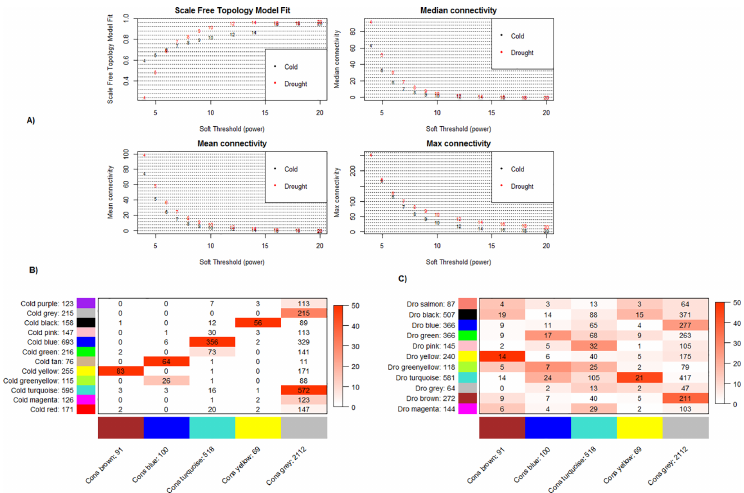
Fig 6. Consensus module detection and comparison. (A) The plots depicting various network indices (y-axes) as functions of the soft- thresholding power (x-axes). Numbers in the plots represents soft-thresholding powers. The plots demonstrate that 10 is the smallest soft-thresholding power at which approximate scale-free topology is accomplished for both sets as the various connectivity measures decrease sharply with increasing soft-thresholding power. (B) and (C) Relation between consensus modules and modules found individually in cold and drought expression set. The table represents the analogy between consensus modules and modules of cold and drought stress related global co- expression network based on the expression values of the common genes. Each row of the table represent individual stress specific module and each column represent one consensus module. Numbers in the table represent genes common between individual stress module and consensus module. The table coloring pattern represents the negative log of Fisher’s exact test p-value for the overlap of the two compared modules. The darker red color represents more significant